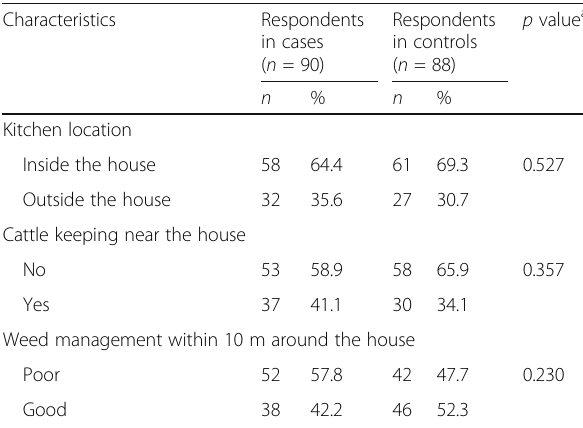
Table 4 Bivariate analysis of the associations